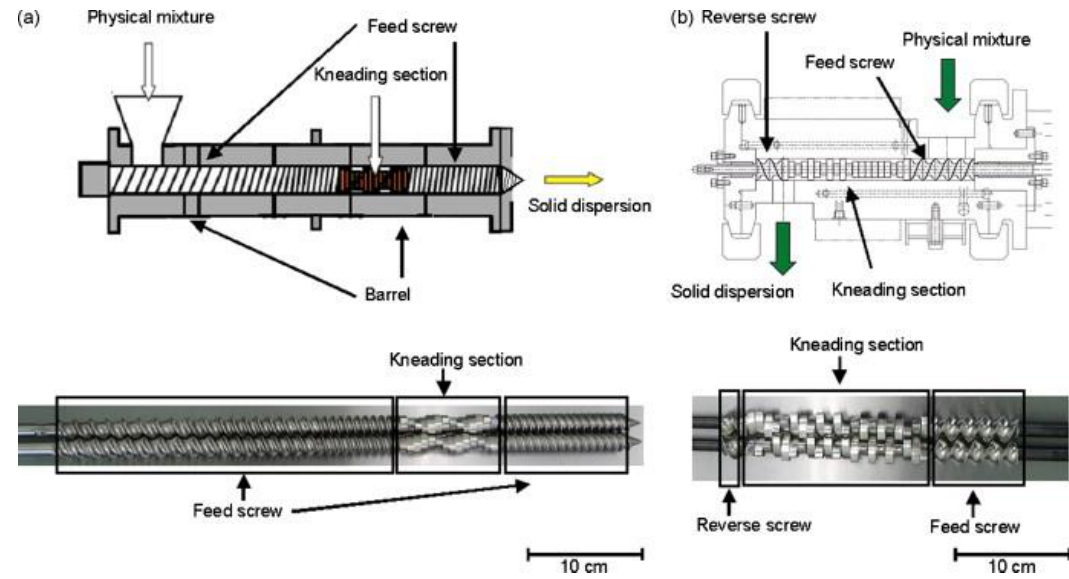
Figure 10. Schematic view of the ( a ) extruder and ( b ) kneader. Reproduced with permission from Y.